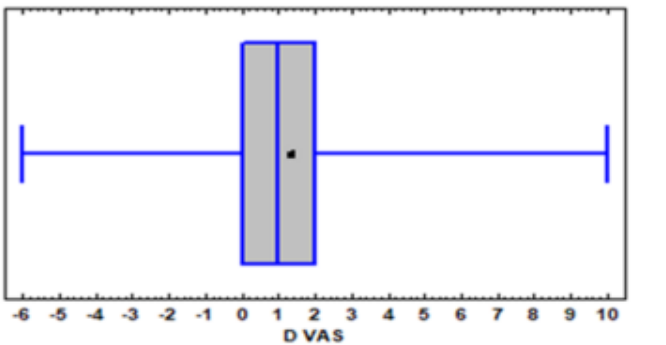
Figure 1. DVAS Box and whisker plot of ∆ VAS score distribution after a month of treatment with cannabis. The average ∆ VAS value is represented by the X.